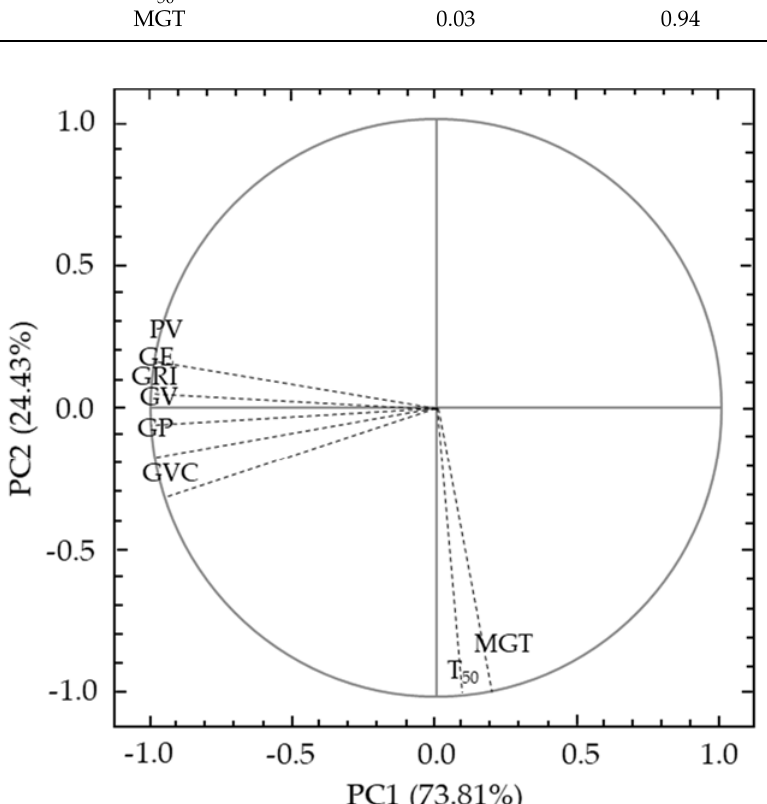
Figure 2. Site score plot of the studied variables on the first two principal components (PC1 and PC2) of Salicornia europaea seeds exposed to salt stress. GP, germination percentage; GE, germination energy; PV, peak value; GV, germination value; GRI, germination rate index; CVG, coefficient of velocity of germination; T 50 , time to reach 50% of germination; MGT, mean germination time (MGT).